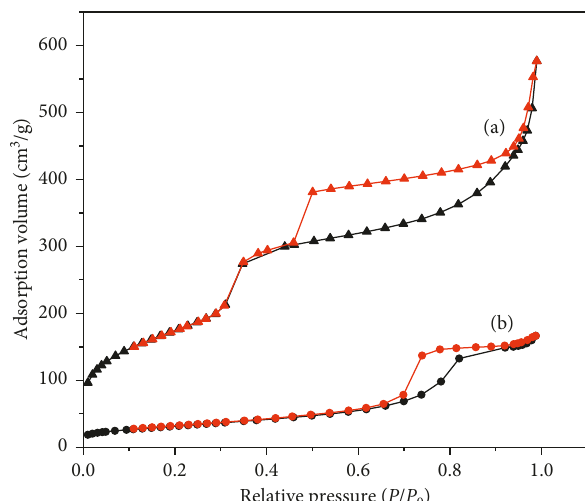
Figure 6: N 2 adsorption-desorption isotherms of (a) Al-MCM-41 and (b) Al-MCM-41@0 1Ag/TiO 2